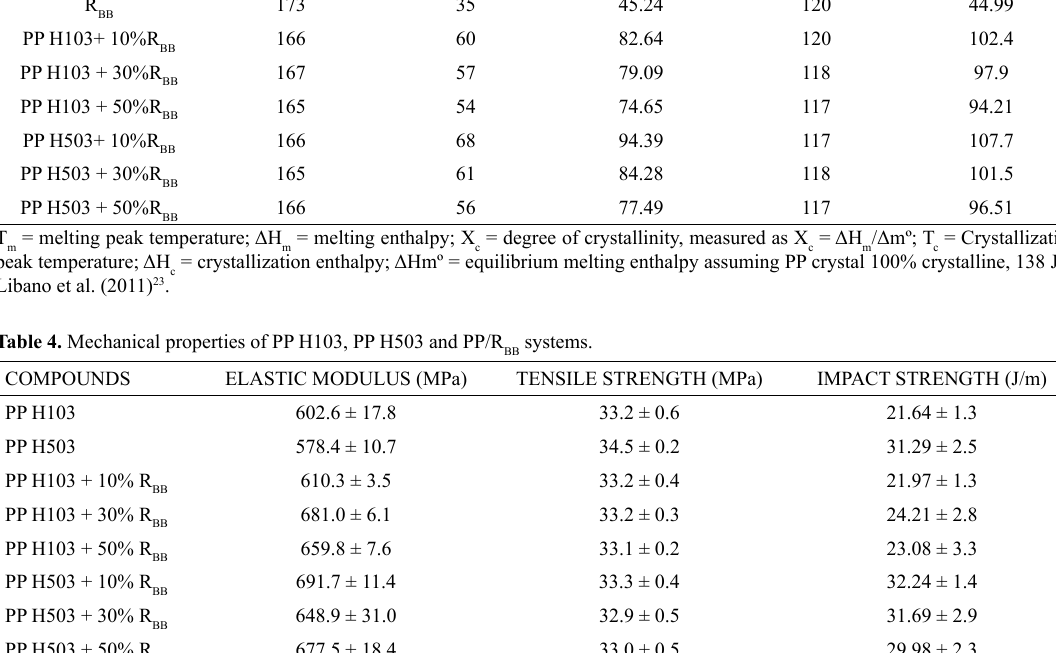
Table 3. Melting and crystallinity parameters of PP H103, PP H503 and R COMPOUNDS